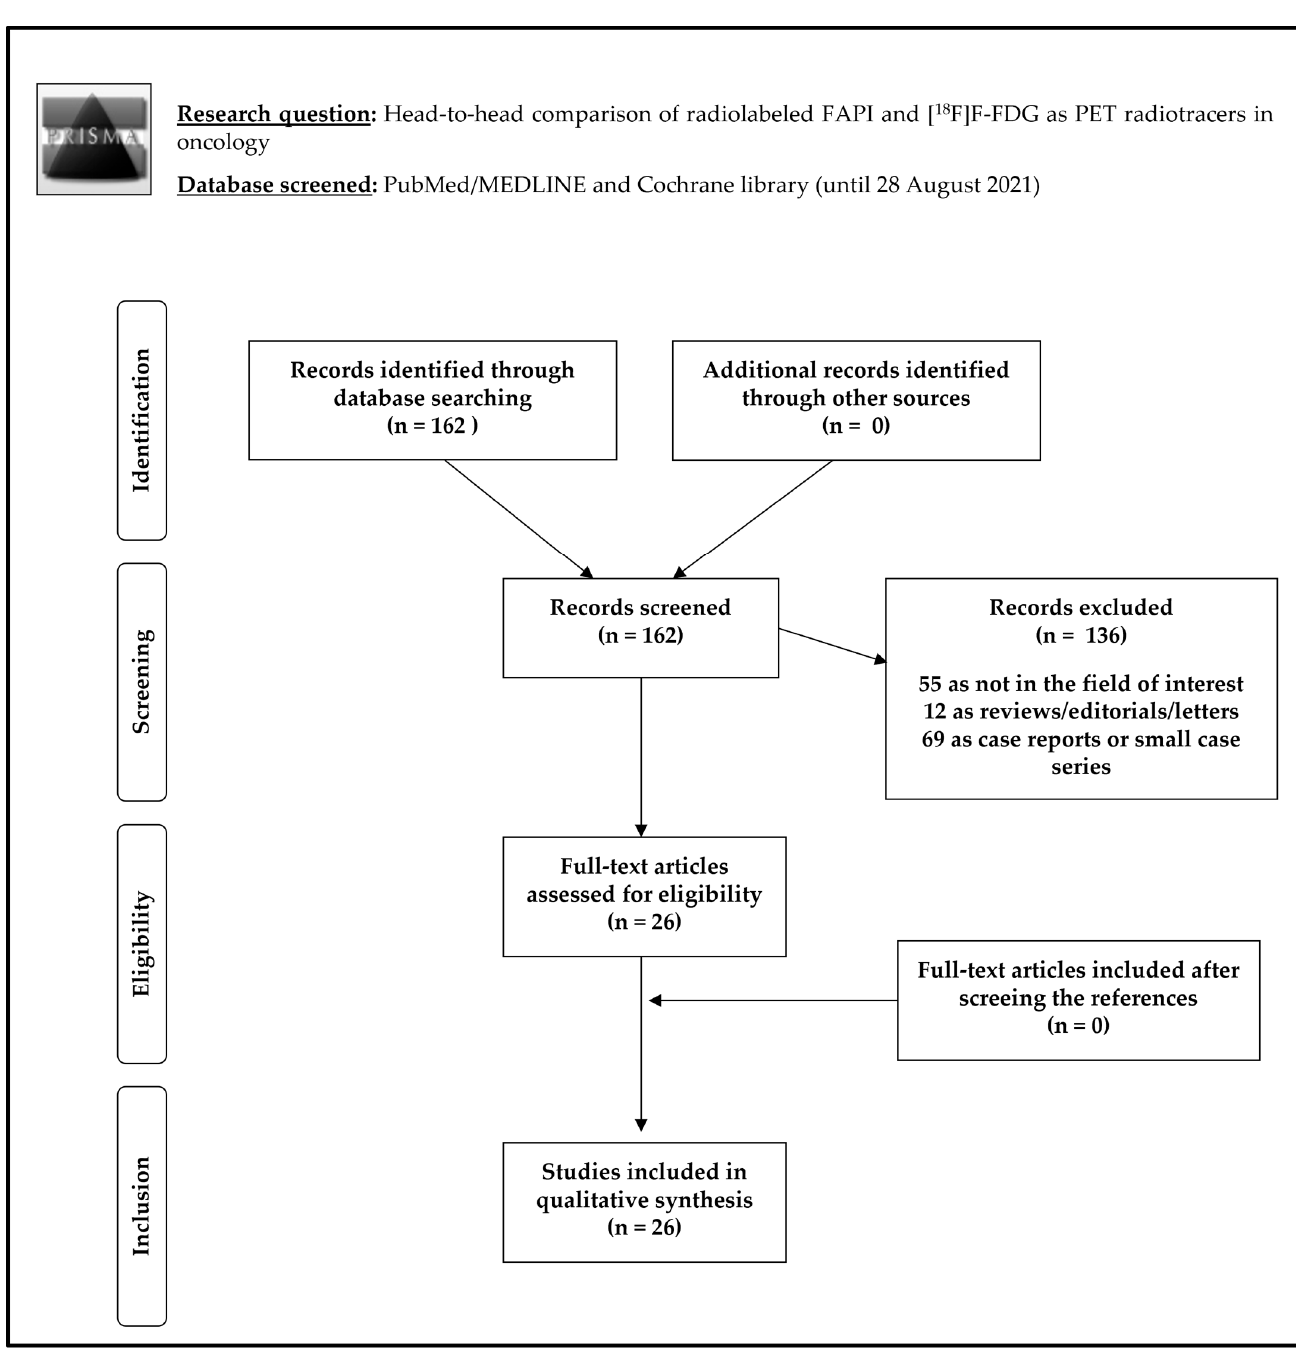
Figure 1. Scheme of article selection for the systematic review.